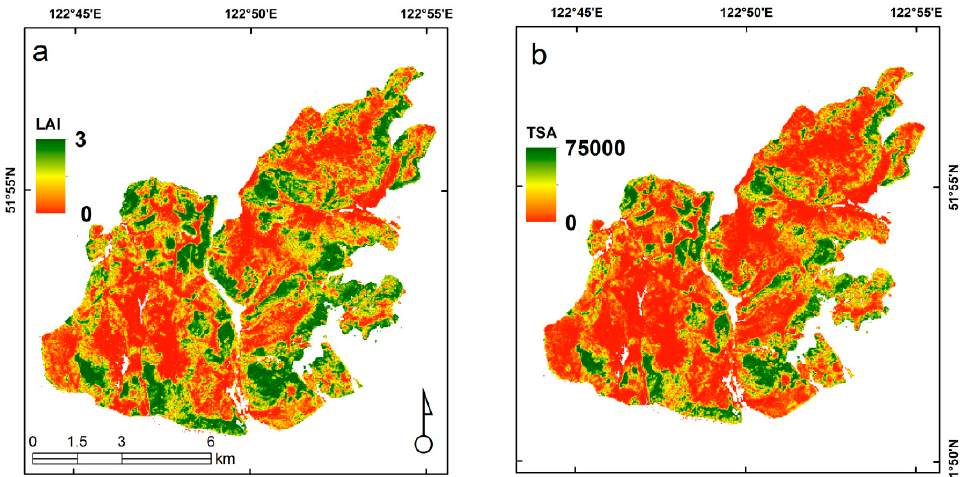
Figure 5. Two maps show spatial distribution of Leaf Area Index (LAI, a ) and Tree Sapling Abundance (TSA, b ) based on Pixel Percentage of Canopy Tree (PPCT) derived from WorldView-2 image.